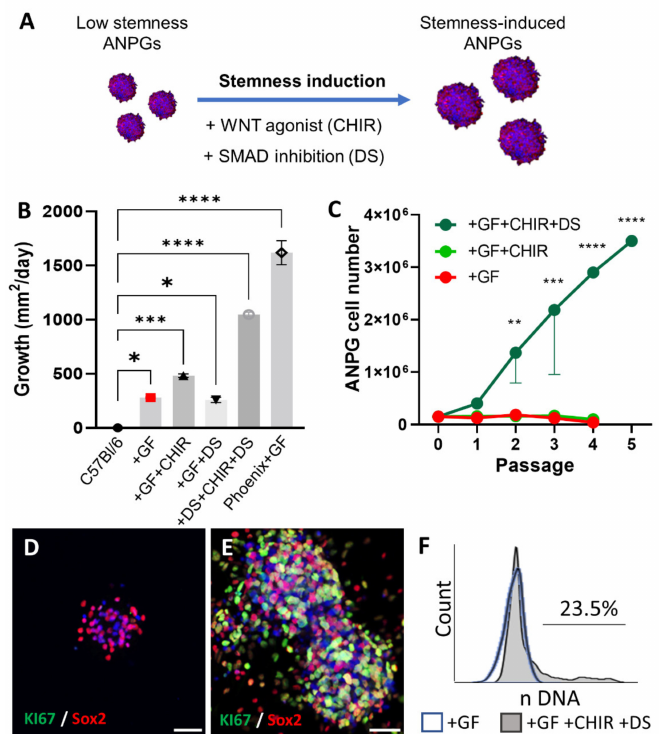
Figure 5. Neurosphere stemness induction in low propagating ANPGs from a C57Bl/6 mouse . ( A ) C57Bl/6 ANPG were plated at 10,000/well of a 96-well plate and treated with WNT agonist (CHIR99021; 3 µ M) and/or TGF β Smad antagonist (dual SMAD inhibitors; LDN193189 0.5 µ M, SB431542 10 µ M) aiming at replicating phoenix ANPG pattern of gene expression and subsequent stemness phenotype. ( B ) Growth of ANPG neurospheres was followed twice a week over 38 days and the bar graph shows the average growth/day. Phoenix cells are used as positive